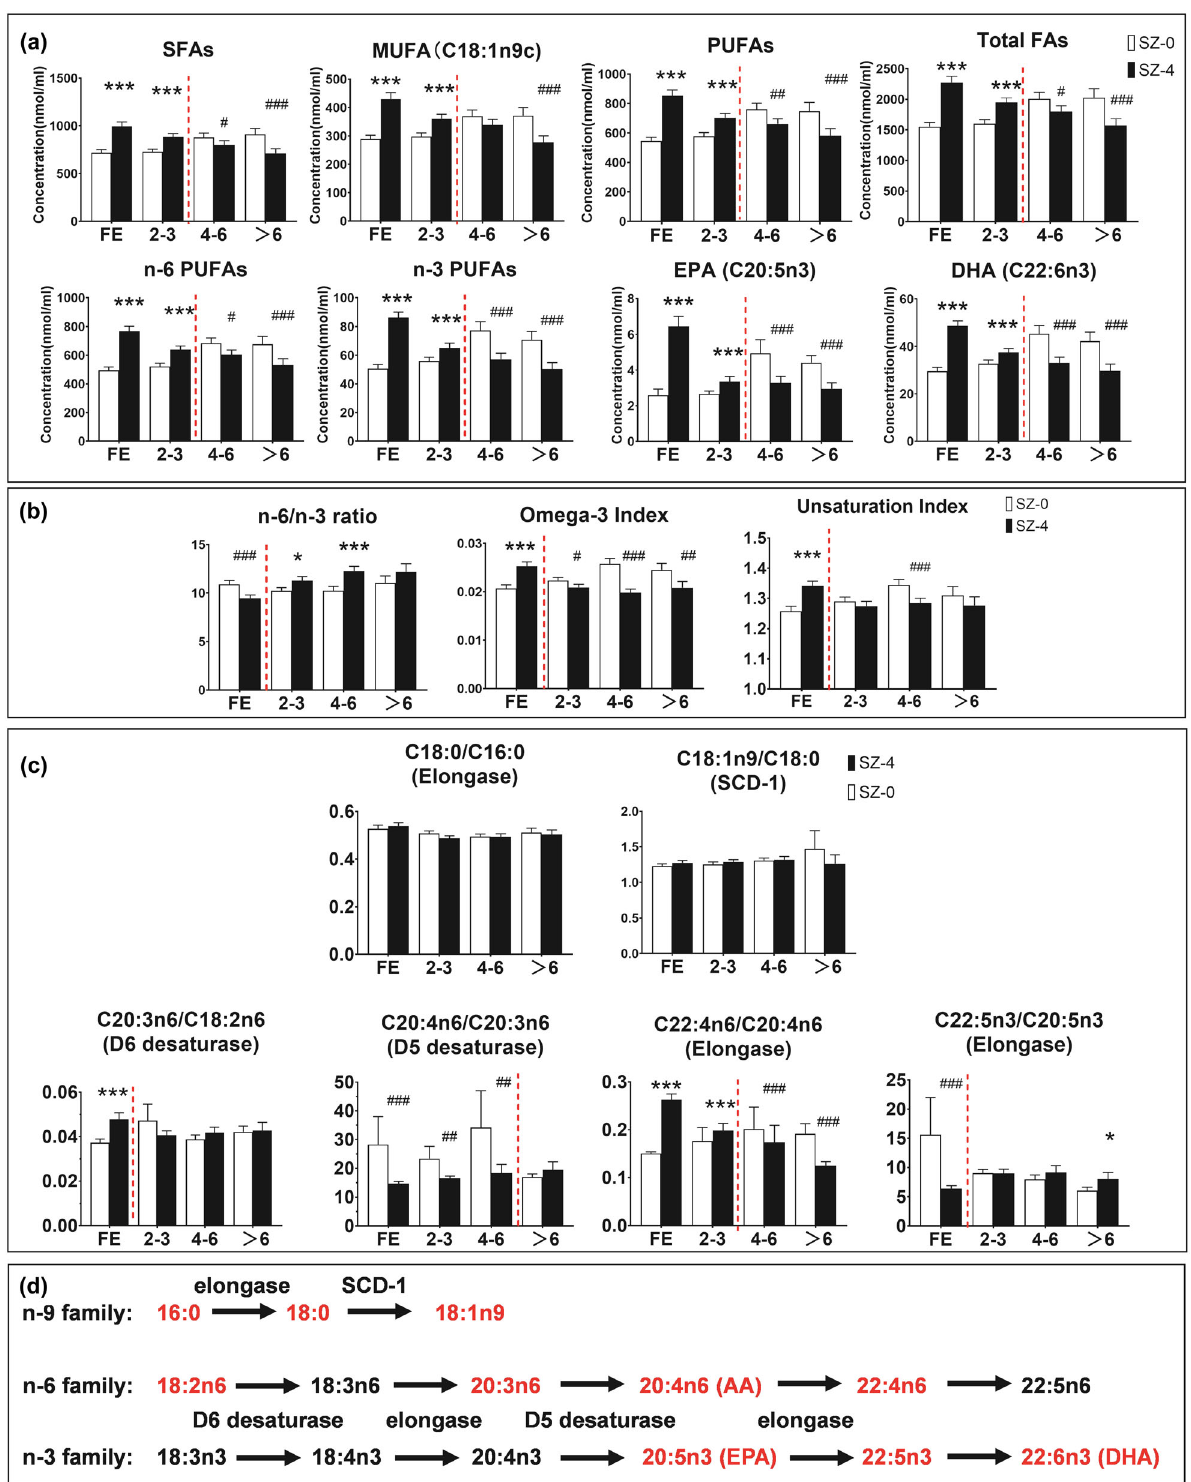
Fig. 3 Differences in membrane fatty acid levels and ratios between baseline and after antipsychotic treatment in patient subgroups divided by episodes. a EPA (C20:5n3), DHA (C22:6n3) and summations for SFAs, MUFAs, PUFAs, n-6 PUFAs, n-3 PUFAs, and total FAs; b n-6/n-3 ratio, omega-3 index and unsaturation index. c Fatty acid ratios that present corresponding enzymes in the fatty acid synthetic pathways; d the synthetic pathways of fatty acids. SCD-1, stearoyl-coenzyme A desaturase-1. The fatty acids in red text indicate the types of speci fi c fatty acids we analyzed in this study. The red dotted line divides the opposing trends of changes among the four subgroups. FE, fi rst-episode; MUFAs, monounsaturated fatty acids; EPA, eicosapentaenoic acid; DHA, docosahexaenoic acid. Plots are shown as the means and standard errors. The Wilcoxon signed rank test was used. * p < 0.05, ** p < 0.01, *** p < 0.001 for increase; # p < 0.05, ## p < 0.01, ### p < 0.001 for